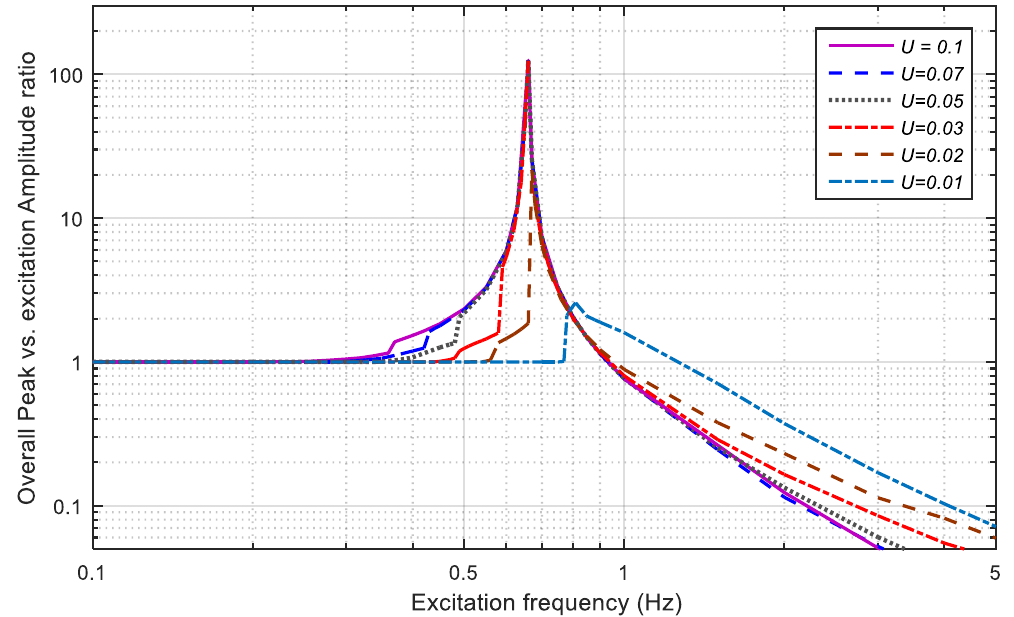
Figure 9. Overall response vs. excitation amplitude ratio according to the amplitude U in case of k / M = 5 and ς r = 0.3 .